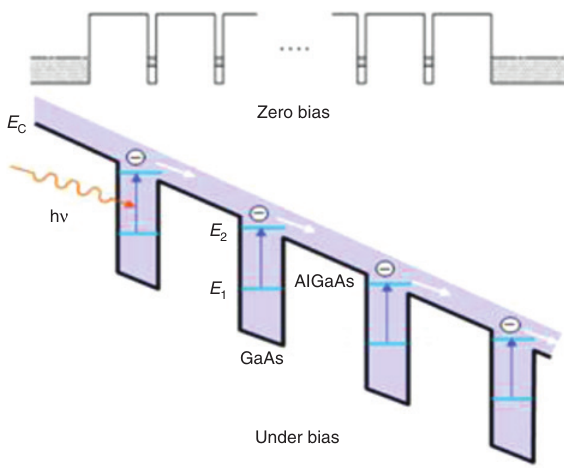
Figure 2: The low-temperature energy bandgap diagram of different semiconductors with diamond and zinc-blende structure versus their lattice constants by Nobel Laureate Esaki [41].